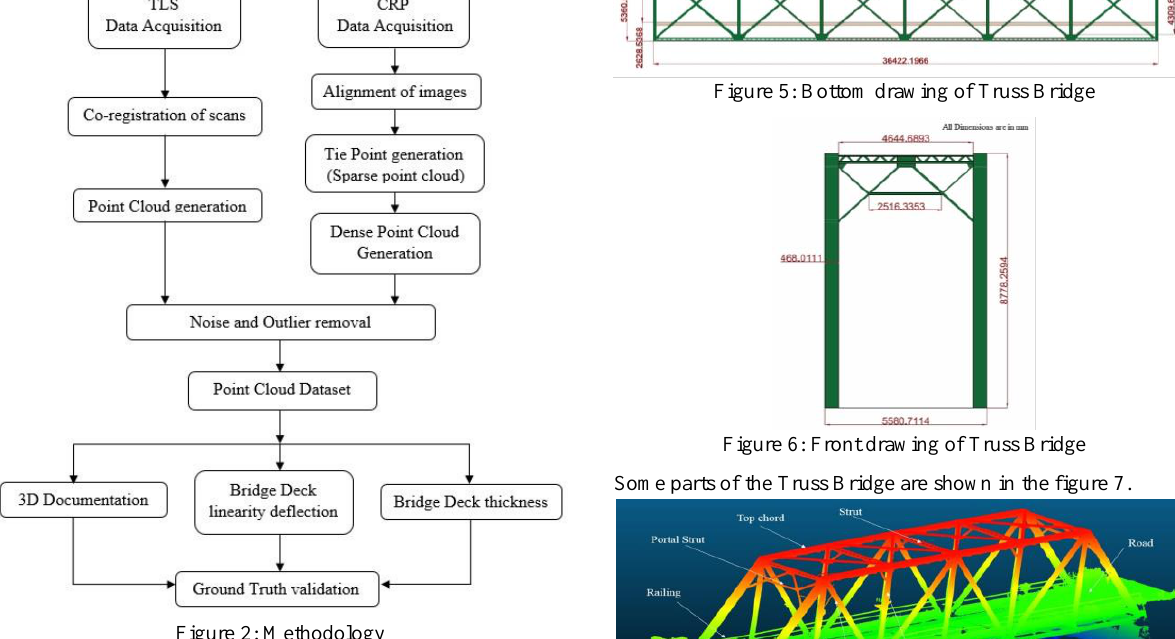
Figure 5: Bottom drawing of Truss Bridge